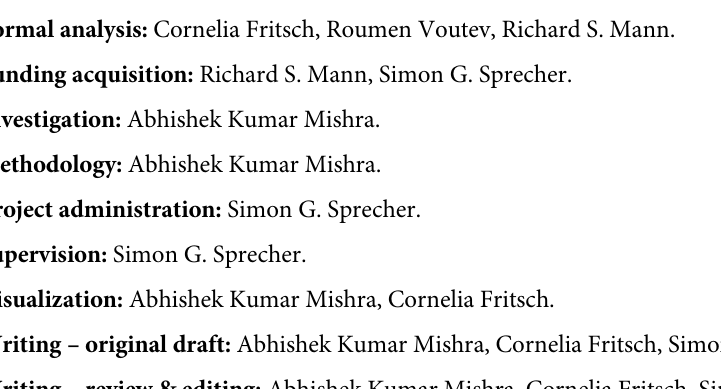
S6 Fig. A table for knockdown mini-screening candidates in the ocelli. The table consists of candidates either known to have interactions with Hth (information from Flybase) or they have been previously found to regulate Rh2 expression [40]. For knockdown screening, flies were ordered from Bloomington’s Drosophila stock center and the stock numbers are listed in the table.